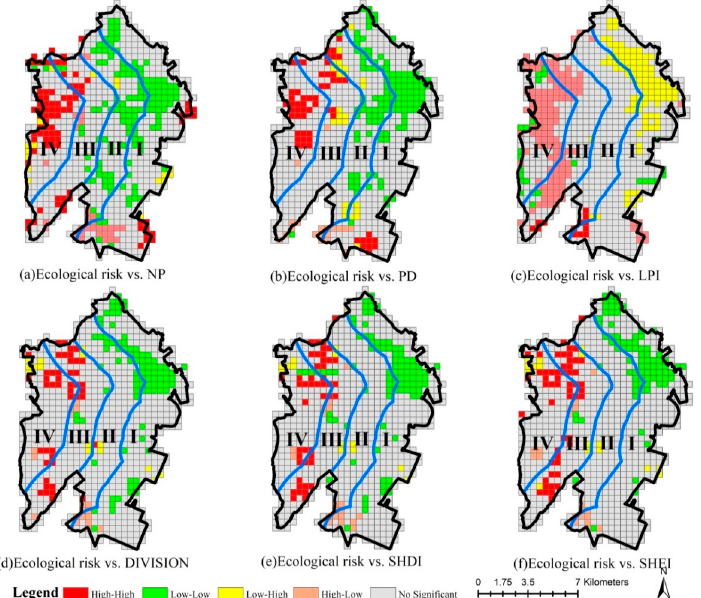
Figure 10. LISA cluster map between ecological risk change and landscape metrics changes from 2005 to 2020. (Gradient I (0–2 km), gradient II (2–4 km), gradient III (4–6 km) and gradient IV (>6 km) from the coastline to the inland).